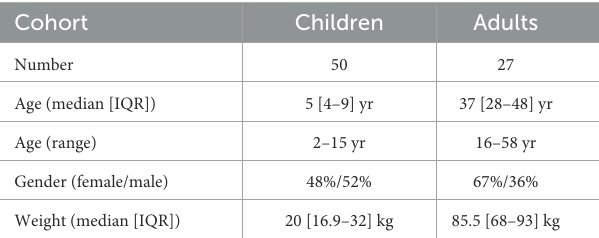
TABLE 1 Patients demographic